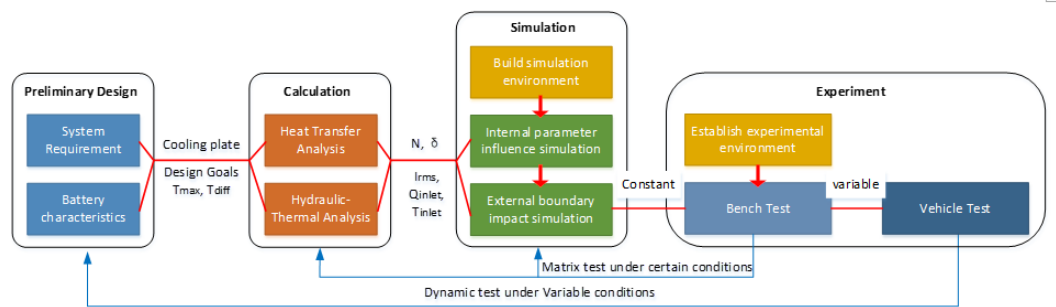
Figure 1. Organization of the study.